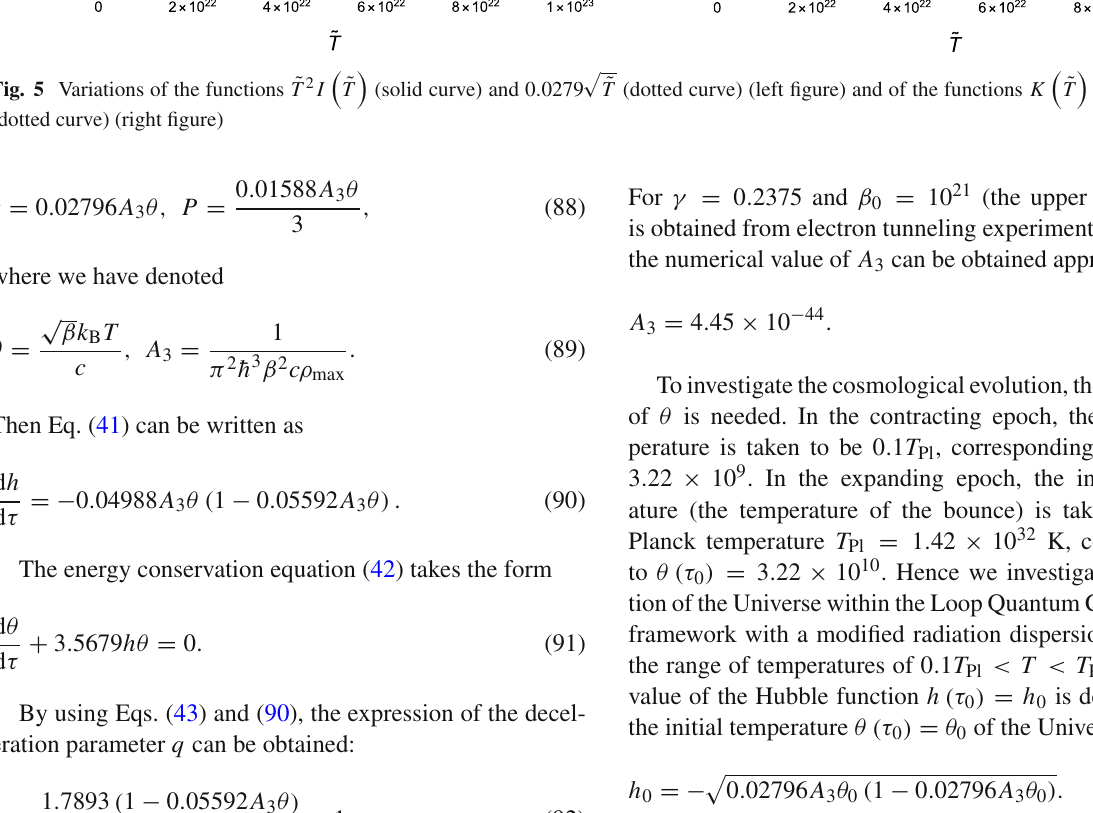
(cid:7) (cid:8) (cid:2) ˜ T ˜ T and 0 . 0159